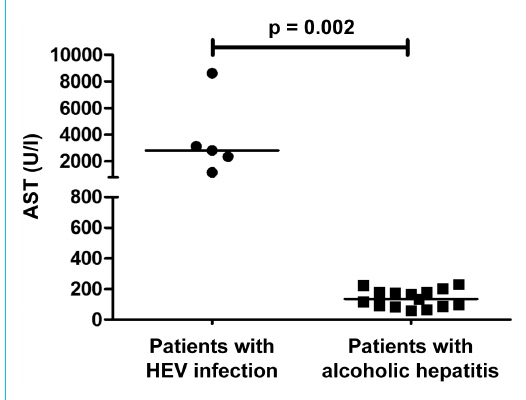
Figure 2: Comparison of aspartate aminotransferase (AST) levels at presentation between the five patients with hepatitis E virus (HEV)-related acute-on-chronic liver failure and 15 matched pa- tients with severe alcoholic hepatitis. The horizontal line within each plot represents the median and the circles/squares represent the AST levels at presentation for each patient. Statistical analysis was performed using the Mann-Whitney